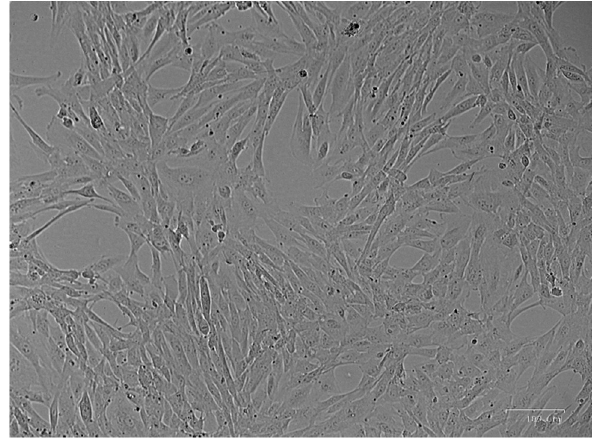
Figure 1. Image of the culture of hUSCs at passage 2 taken using a ZOE™ Fluorescent Cell Imager. Homogeneous spindle-shaped cells are shown. Scale bar: 100 μ m. Table 1. Percentage of positive cells for each cell surface marker studied by flow cytometry. CD73, CD90, and CD105 correspond to antigens that are present specifically in mesenchymal stem cells. However, CD14, CD34, and CD45 are absent in MSCs. The different fluorophores used were FITC, APC, PE, and AlexaFluor488.